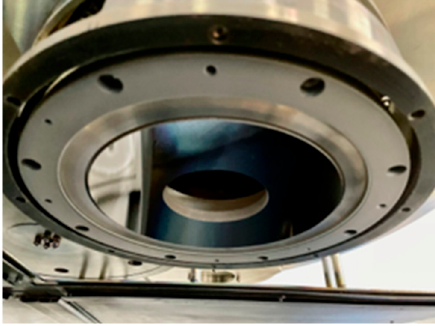
Figure 17. The mirror in the chamber.